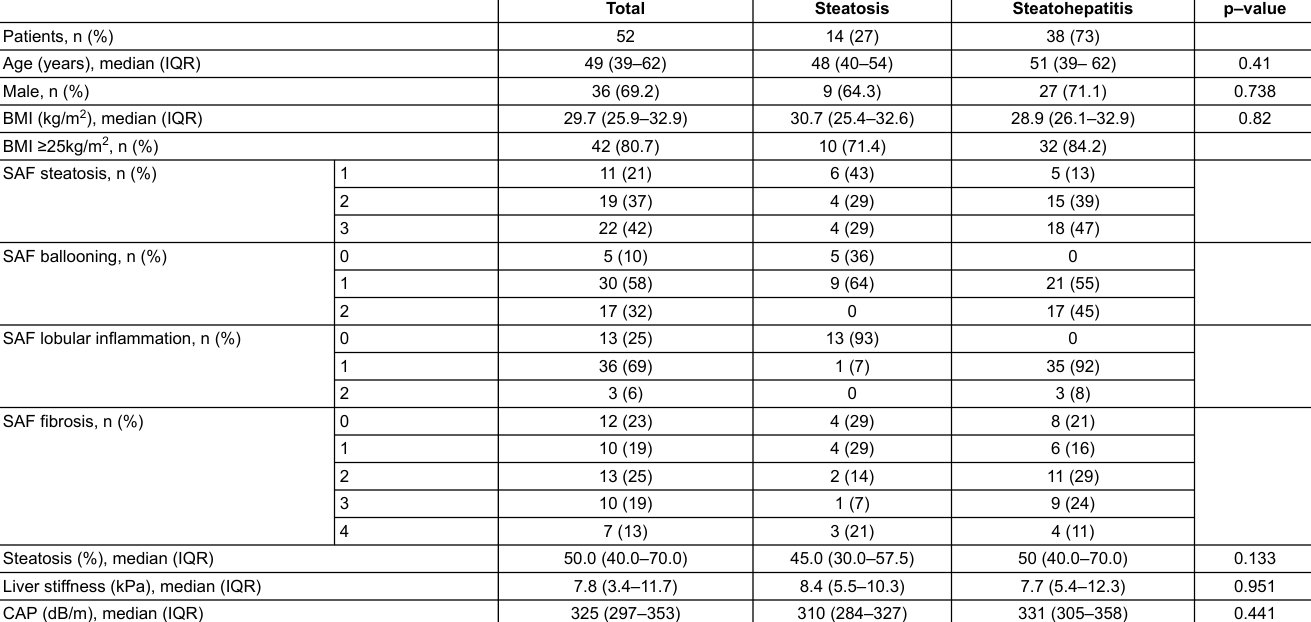
Table 2: Characteristics of patients with non-alcoholic fatty liver